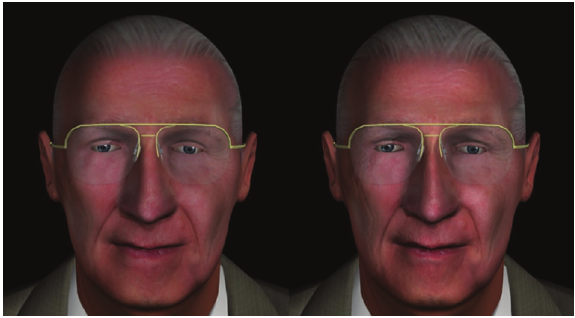
Figure 20. A Comparison of the Avatar with (Right) and without (Left) a High-Resolution Paral- lax Normal